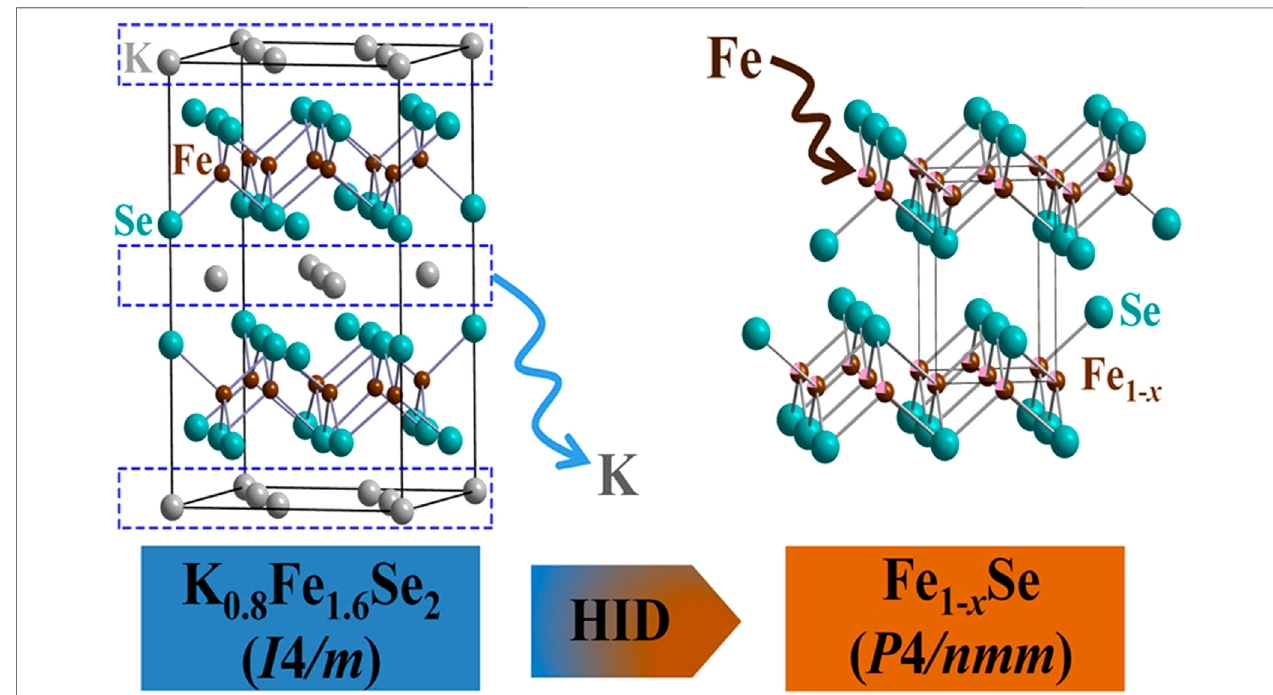
FIGURE 2 | Scematic llutration of the hydrothermal ion-deintercalation method. During the HID process, Fe 1- x Se single crystals are derived from the readily obtainable phase-pure matrix single crystals of K 0.8 Fe 1.6 Se 2 . The original interlayer K ions and Fe vacancies (20% in amount) in K 0.8 Fe 1.6 Se 2 were completely de-intercalated and substantially reduced, respectively, yielding the target single crystals of phase-pure Fe 1- x Se [9, 61, 62].